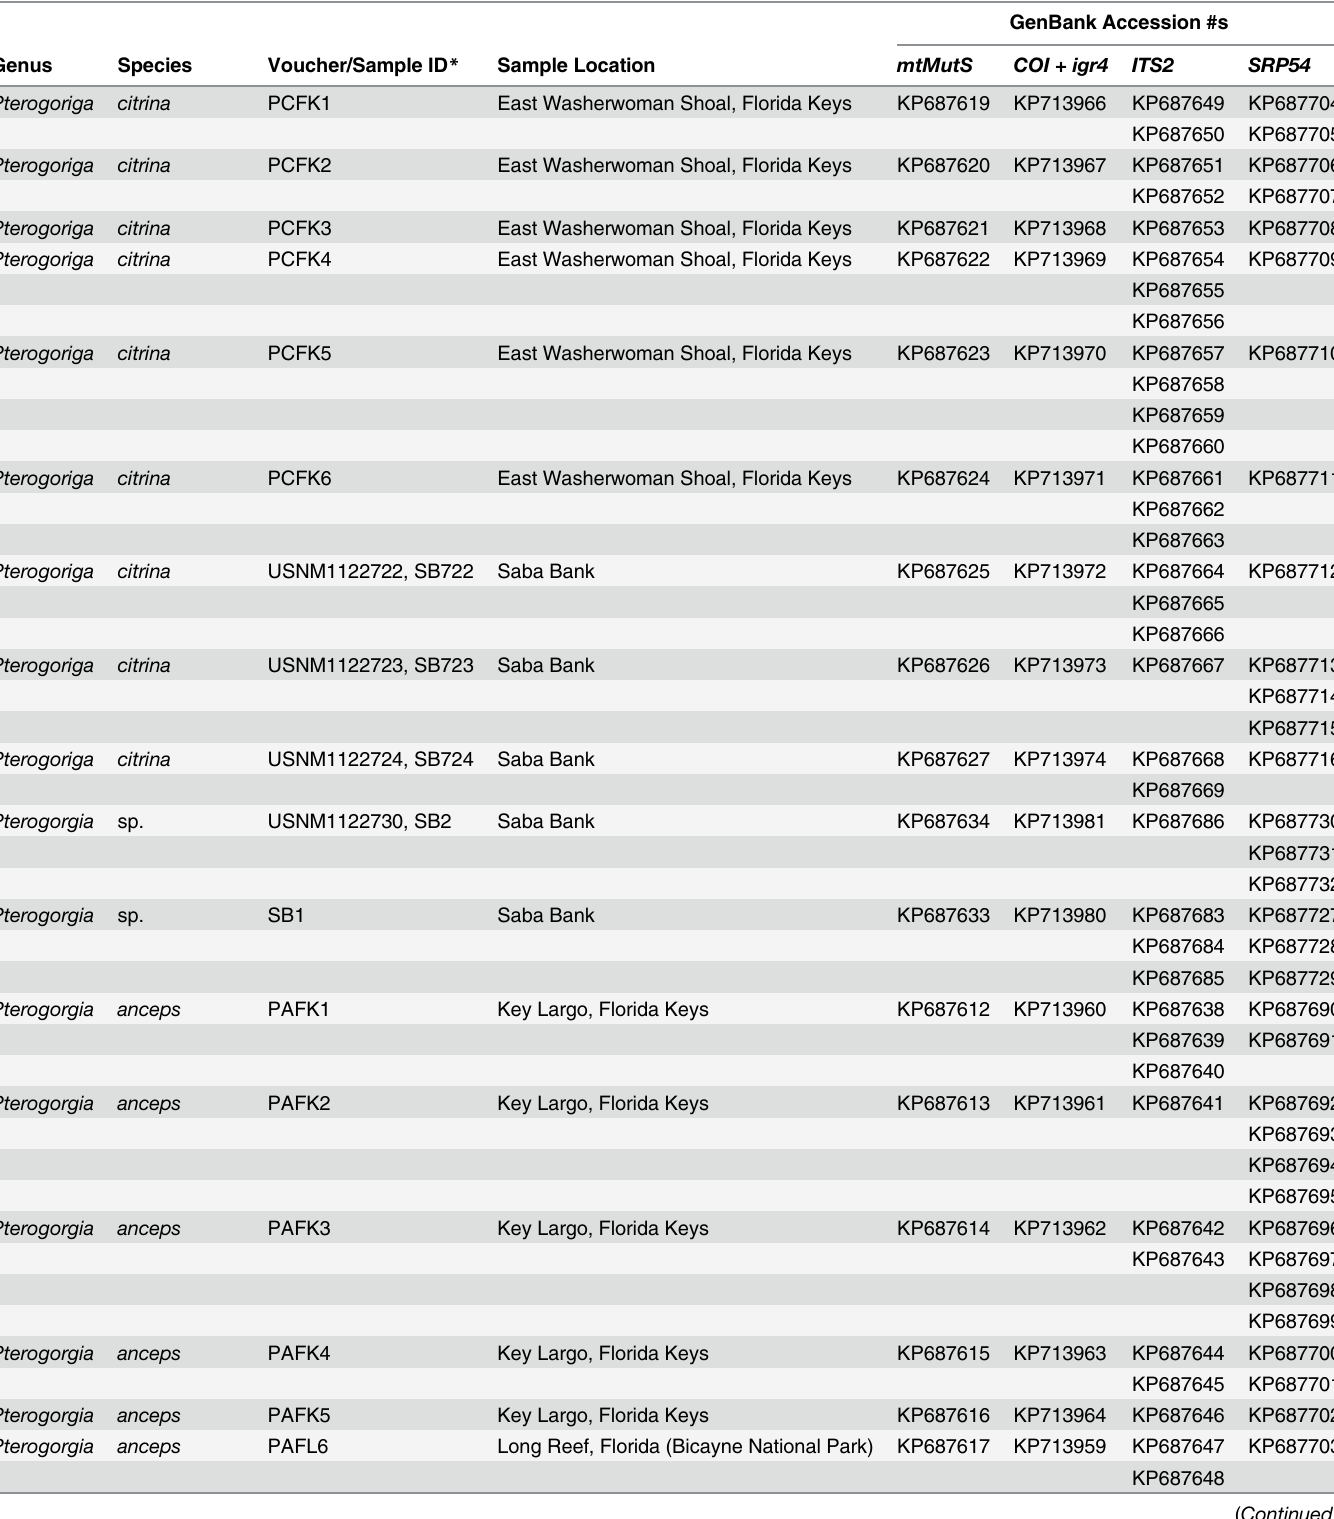
Table 1. Sample information including Voucher/Sample ID * , sample collection locations, and GenBank Accession Numbers. USNM vouchers were relabeled with an "SB" (Saba Bank) for their sample ID in the text and